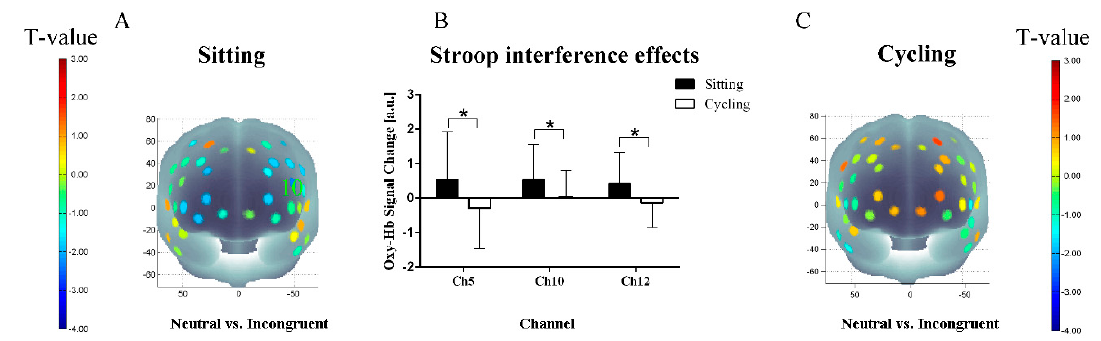
Figure 4. fNIRS results of the Stroop task ( A ) t-map of oxygenated hemoglobin (oxy-Hb) concentrations in the sitting condition; ( B ) Oxy-Hb changes related to the Stroop interference effects; ( C ) t-map of oxy-Hb concentrations in the cycling condition. Data are expressed as mean ± SD. * indicates FDR-corrected P < 0.05).